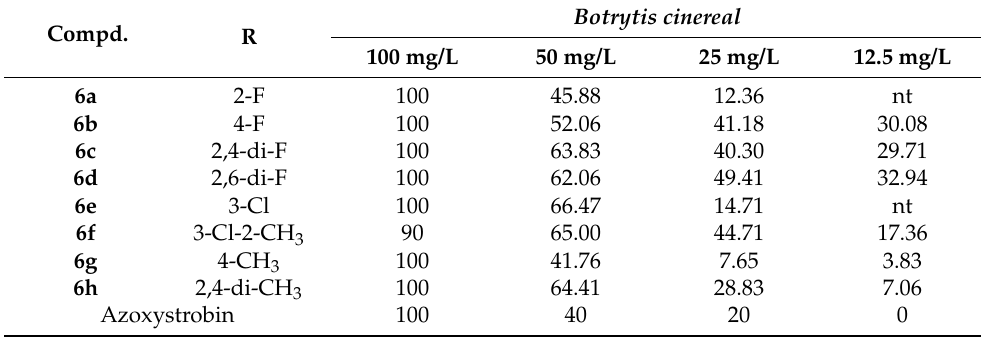
Table 1. Fungicidal activities (inhibition rate/%) on Botrytis cinereal of compounds 6 . Compd. Note: nt = not tested. All the data were determined three times. Table 2. Fungicidal activities (inhibition rate/%) on Rhizoctonia solani of compounds 6 .